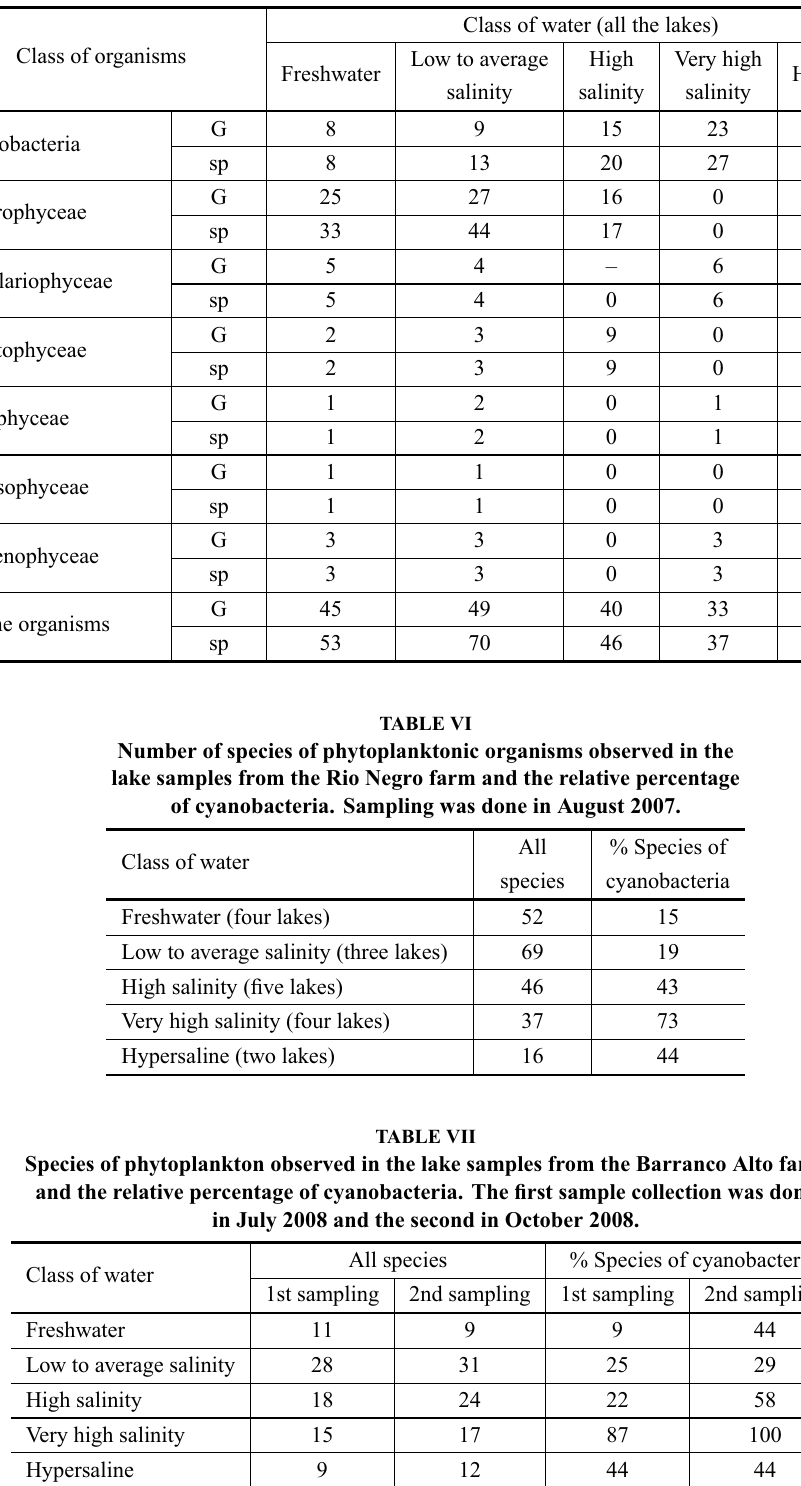
Number of genera and species described by salinity of water classes adopted (G = Genus; sp = species). Class of organisms